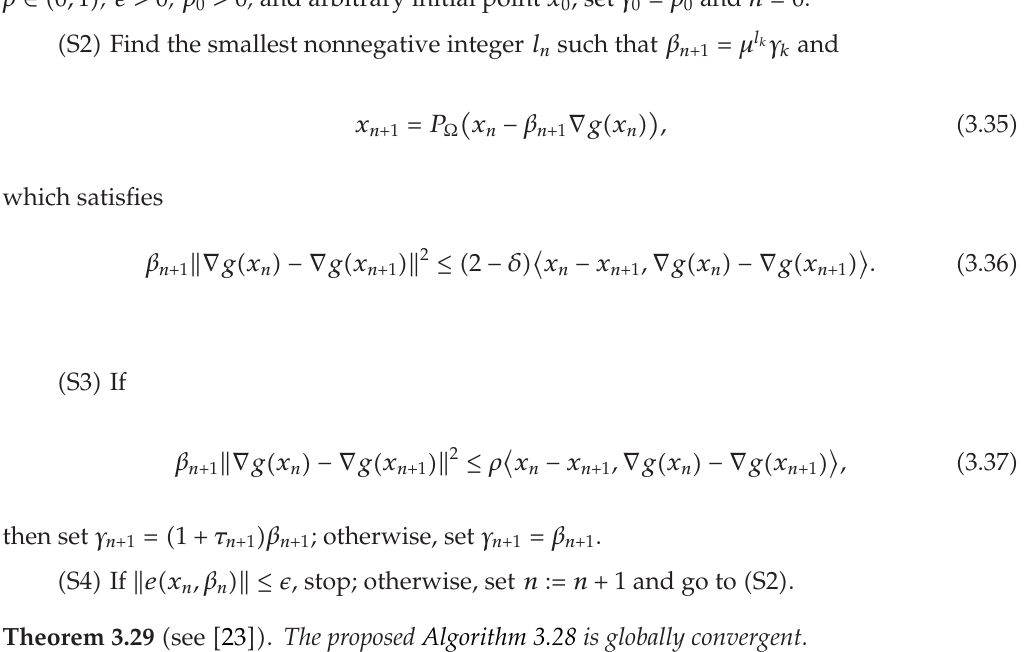
(cid:19) ∞ τ n < ∞ , δ ∈ (cid:2) 0 , 1 (cid:3) , μ ∈ (cid:2) 0 , 1 (cid:3) n (cid:8) 0